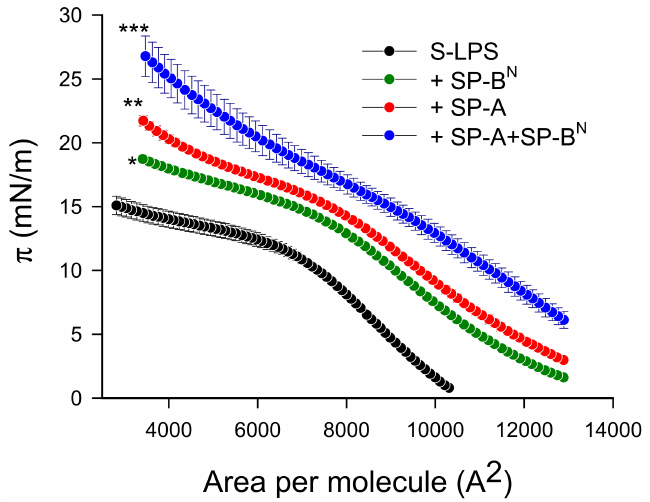
Figure 8. Compression isotherm for the effect of SP-A (1.54 nM) and/or SP-B N (12.5 nM) on the surface pressure ( π ) vs. area isotherms of pure S-LPS monolayers. The temperature of the subphase was 25.0 ± 0.1 ◦ C. A barrier speed of 50 cm 2 /min was chosen as the optimum velocity for the monolayer compression. The results are the mean ± SEM of three experiments. A p -value < 0.001 was obtained for overall one-way ANOVA (Bonferroni-corrected p -value: * p < 0.05, ** p < 0.01, and *** p < 0.001 when compared to the